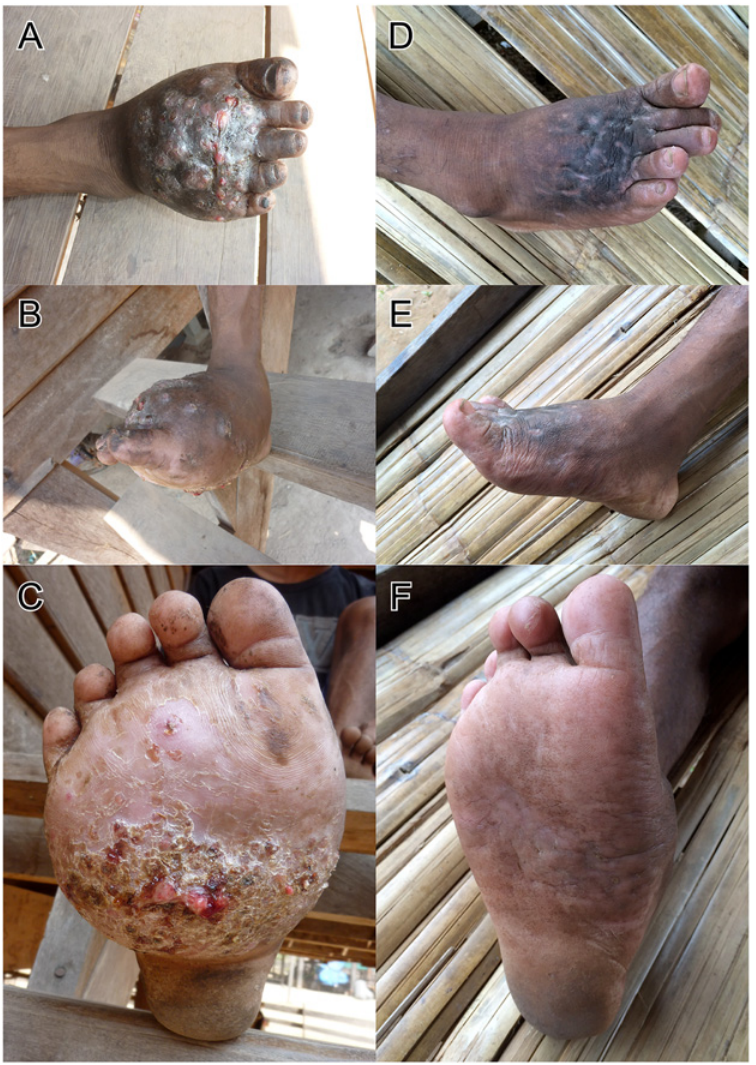
Fig 1. Pictures A, B and C show the right foot before treatment, Pictures D, E and F show the foot 22 weeks after treatment.